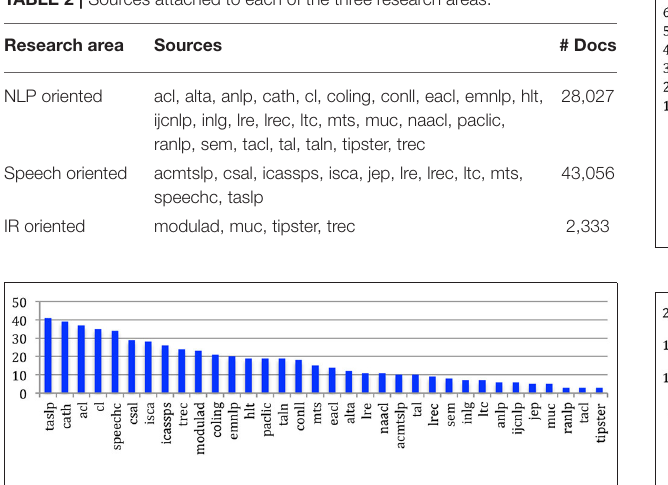
FIGURE 1 | Number of venues or issues for each source.